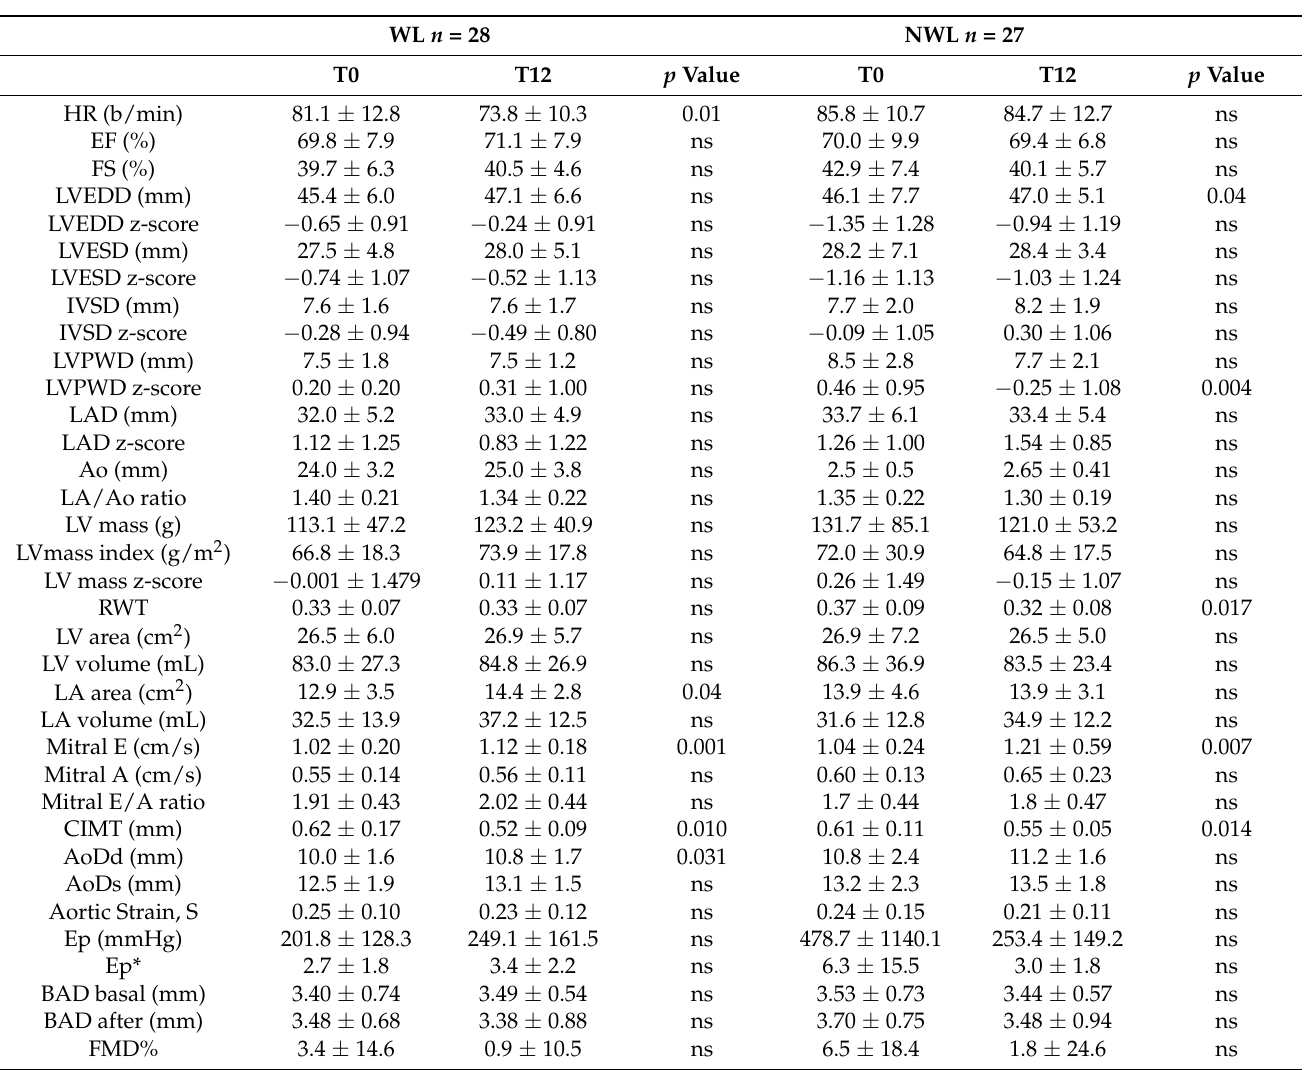
Table 2. Changes in echocardiographic and vascular variables during the 12-months behavioral intervention in weight losers (WL) and non-weight losers (NWL) children with obesity. Values are number (%) or means ±